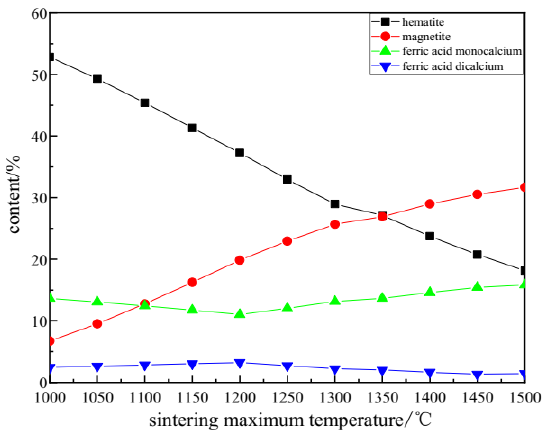
Figure 5. Change of hematite, magnetite, ferric acid monocalcium, and ferric acid dicalcium.